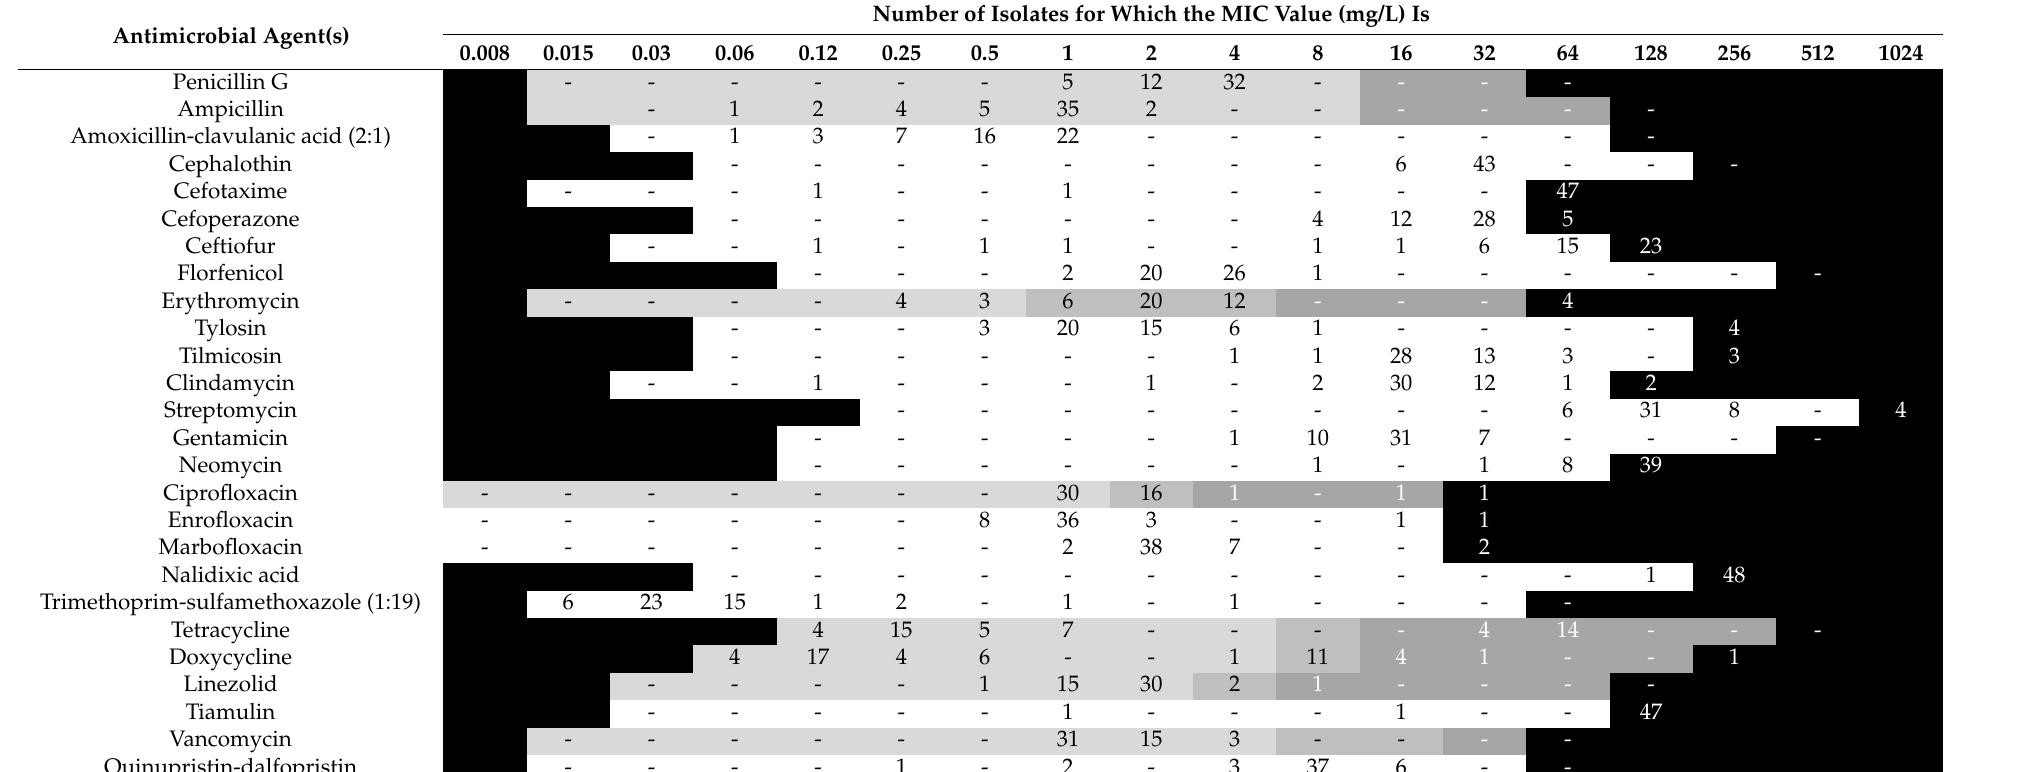
Table 1. Minimal inhibitory concentrations of the 49 canine and feline E. faecalis isolates. Antimicrobial